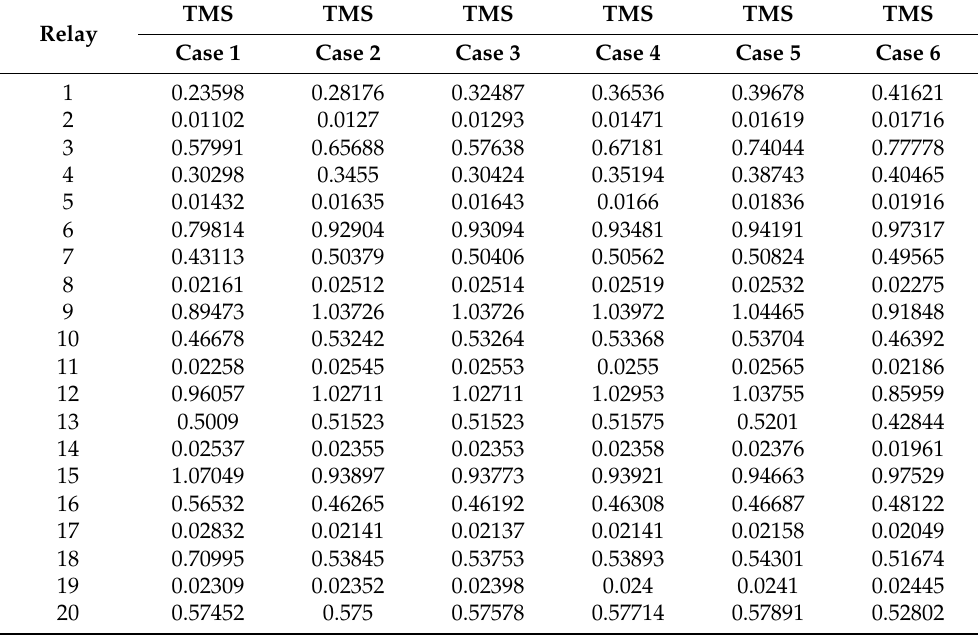
Table 5. Relay TMS parameter optimization using the interior point